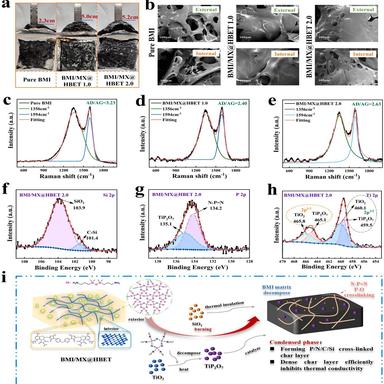
The digital (a) and SEM (b) pictures of char residue of BMI and its composites; Raman spectrum for BMI and its composites (c-e); High-resolution XPS spectra of char residue for BMI/MX@HBET 2.0 of (f) Si 2p, (g) P 2p and (h) Ti 2p; (i) Flame resistance mechanism of BMI/MX@HBET.